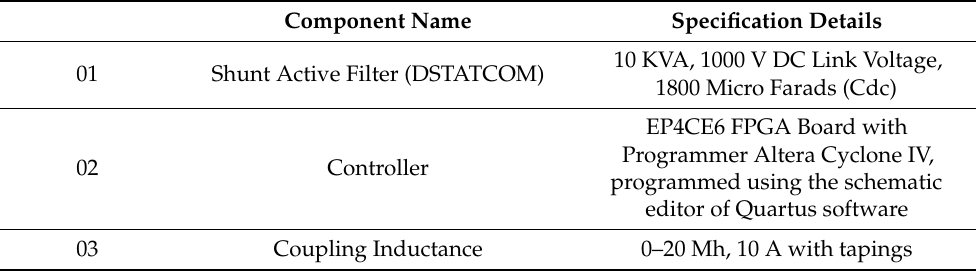
Figure 14. Experimental set-up of the DSTATCOM. Table 2. Hardware components and their